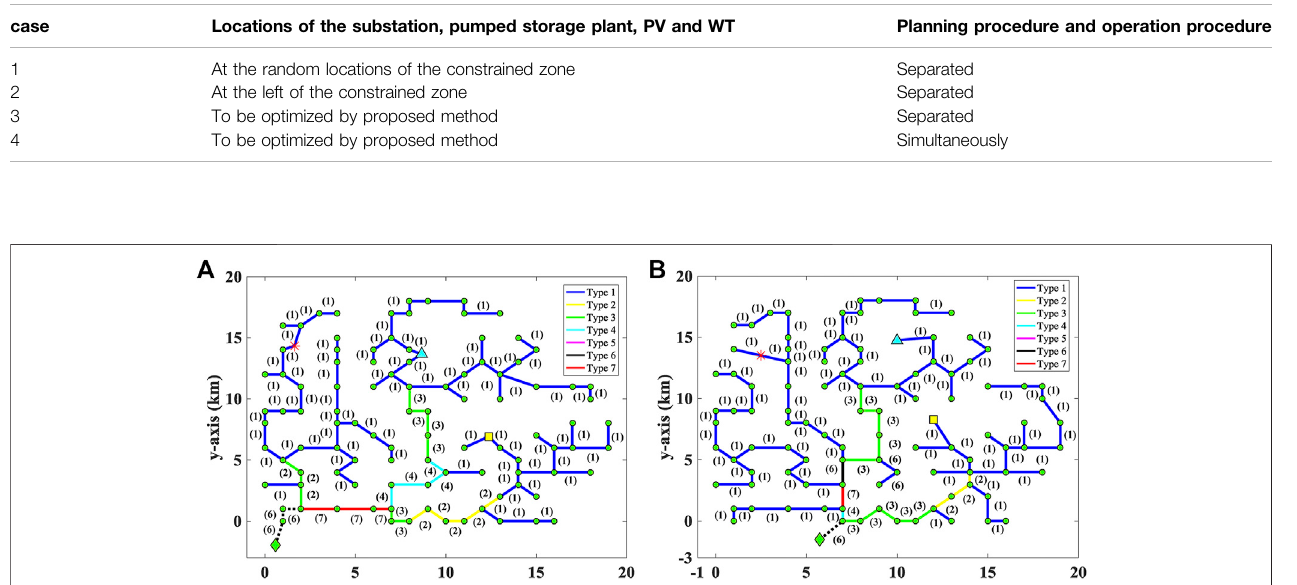
TABLE 3 | Case description.